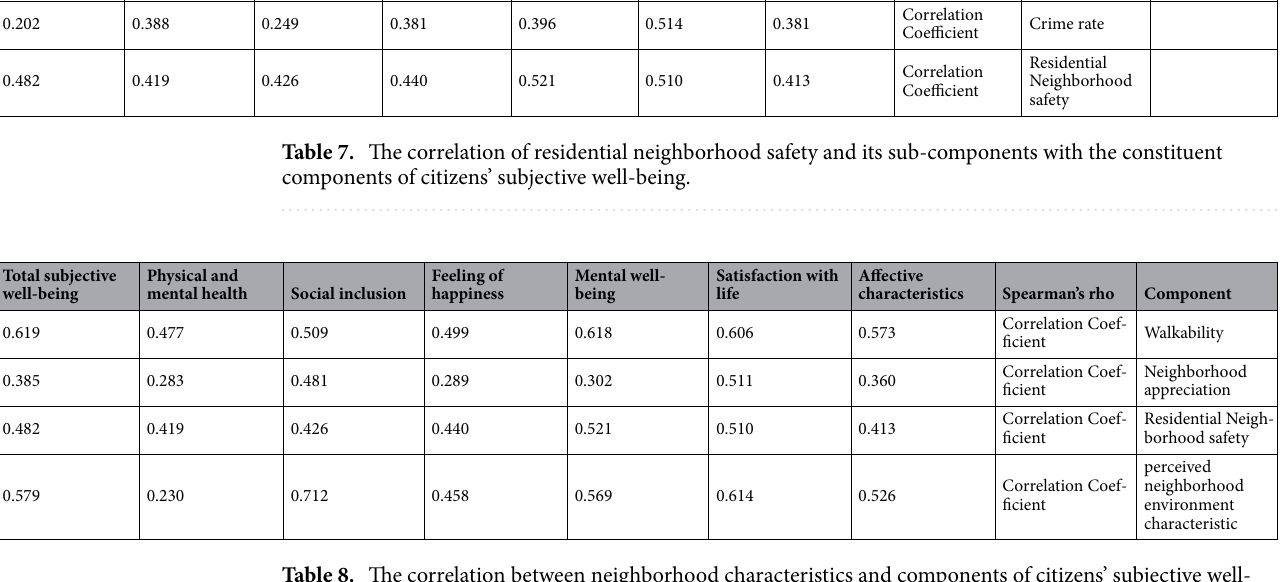
Table 8. The correlation between neighborhood characteristics and components of citizens’ subjective well-